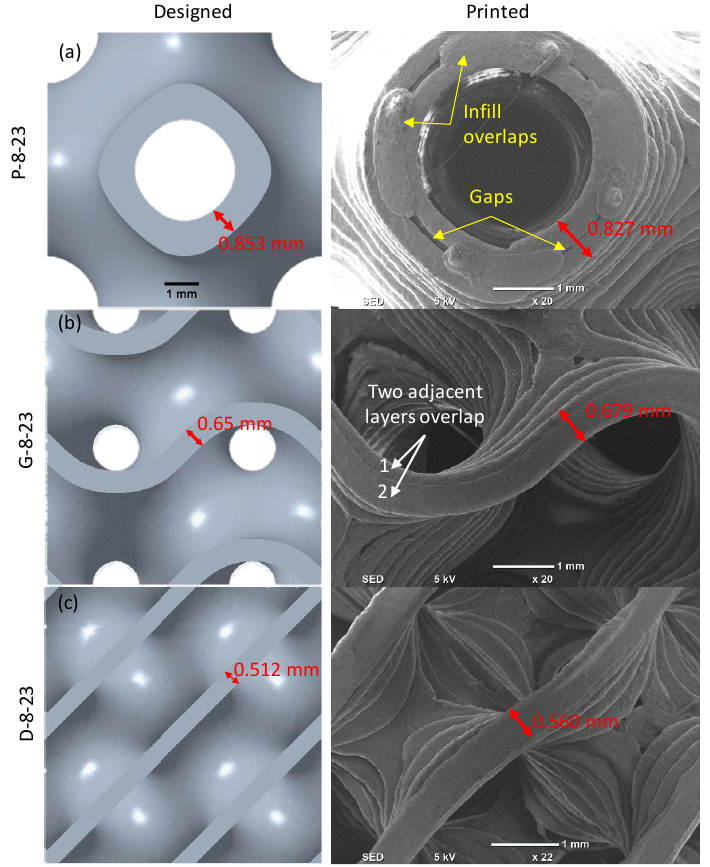
Figure 6. Designed and printed TPMS structures at 8 mm cell size and 23% RD: ( a ) Primitive, ( b ) Gyroid, and ( c ) Diamond.